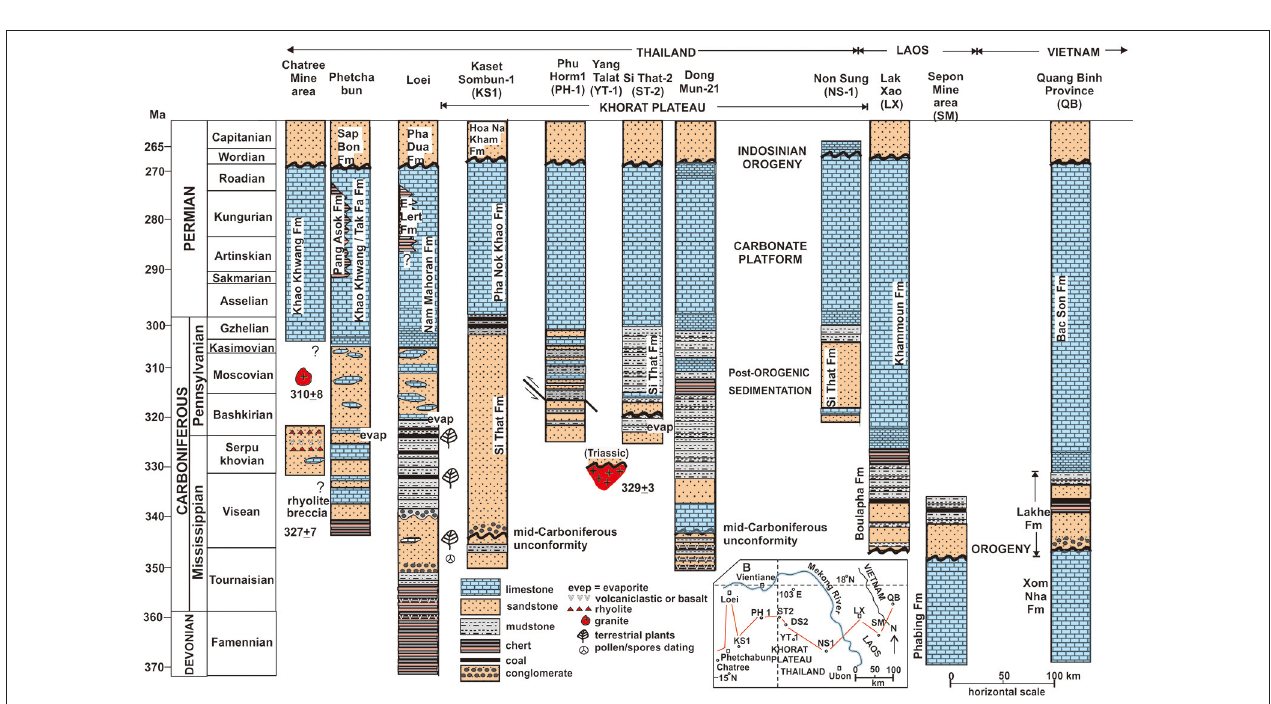
FIGURE 3 | Cross-section from Phetchabun Province in the west to Vietnam in the east. Line of section is shown as A-B on Figure 1 . The Khorat Plateau in NE Thailand and adjacent parts of Laos and Cambodia is covered by the Rhaetic to late Cretaceous terrestrial siliciclastics of the Khorat Group and correlates (Mesozoic siliciclastics in legend). The subsurface geology of the Khorat Plateau is based on seismic interpretations and petroleum wells summarized in Booth and Sattayarak (2011) and Minezaki et al. (2019). The Thakhek Fault in the eastern part of the cross section ( Figure 1 ) is a late Cenozoic transcurrent fault zone due to continued impingement of India into Asia and resultant indentation tectonics. This fault was (and is) active during the Quaternary (Thom et al., 2015) and may be a reactivation of an older structure. Deformation of the pre-Visean strata caused by the Loei-Phetchabun and Truong Son terrane amalgamation in the latest Tournaisian to earliest Visean. Deformation of the Visean and Permian strata was due to subsequent docking of terranes during the Triassic and the Himalayan orogeny.